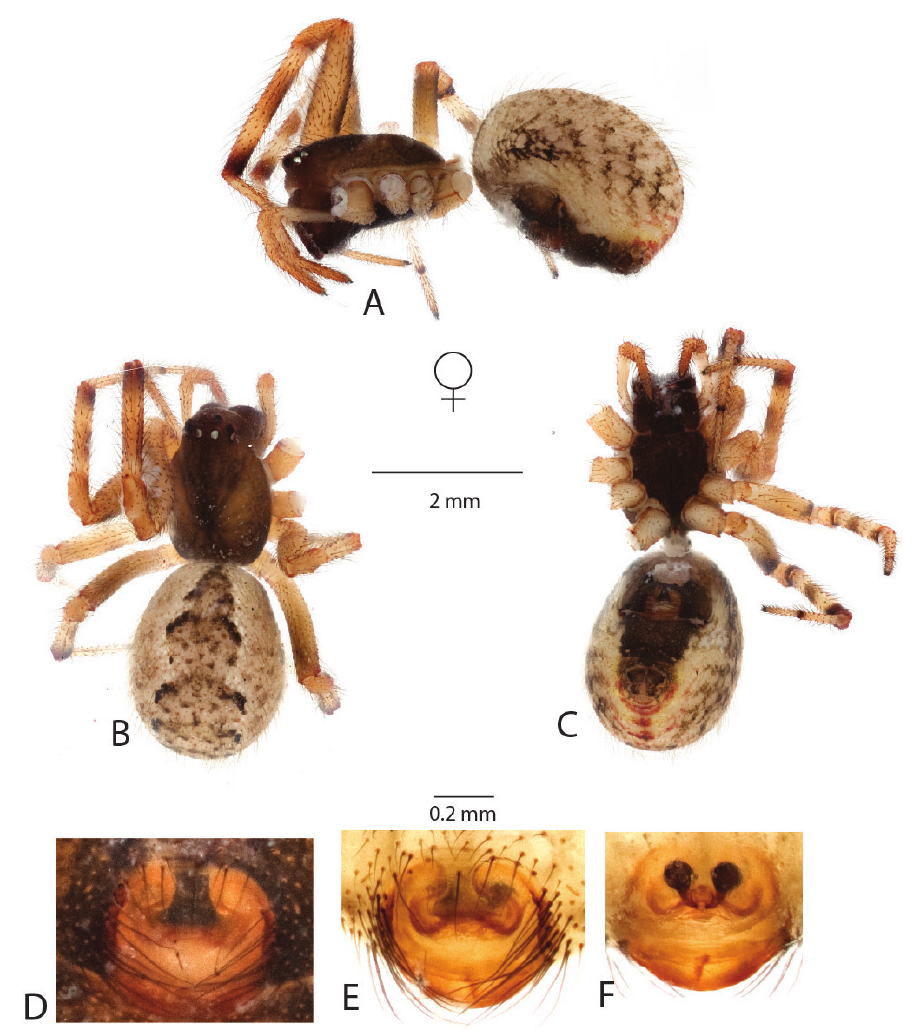
Figure 8. Anelosimus hookeri : A–C female lateral, dorsal and ventral views D epigynum ventral view E–F cleared epigynum ventral, Anelosimus lamarcki Agnarsson & Goh, sp. n. http://zoobank.org/1A46E0A6-99BE-4AFE-BDE1-5FD9C96E36C1 Fig. 9 Type material. Holotype female from Ranamofana National Park (21.25°S, 47.43°E), montane rainforest, 980 1050 m alt, 27.iv.–2.v.2013, col. Pruitt, in NMNH. Other material. Same locality and collection, several adult females.